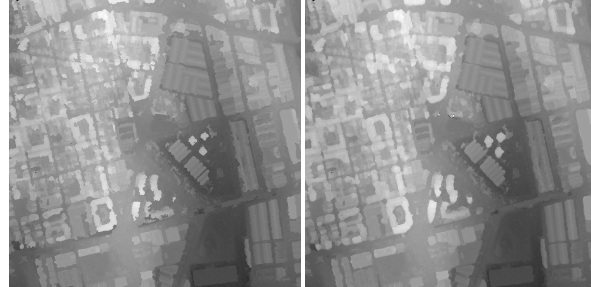
Figure 15: Detail of Terrassa testsite 1 km × 1 km, left DSM filled with proposed method, right DSM filled using inverse dis- tance weighted interpolation